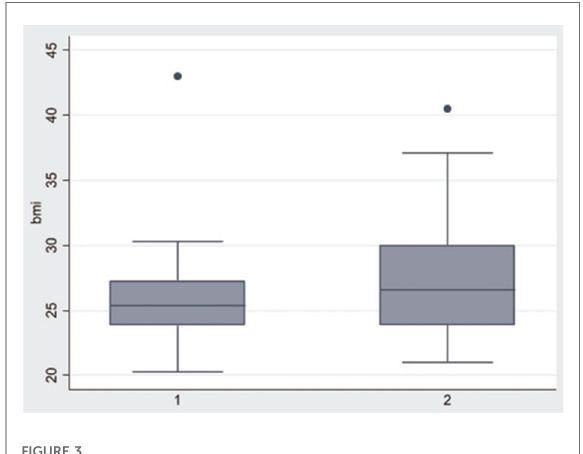
FIGURE 3 Boxplot BMI across groups.